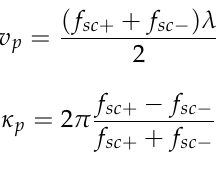
( c ) Figure 6. FEM models for the three types IDTs: ( a ) bidirectional IDT, ( b ) EWC/SPUDT, and ( c ) split IDT. The thickness of Al is normalized by the SAW wavelength λ , which equals the IDT period. The thickness of 128 ° YX-LiNbO 3 and PML were 5 λ and 1 λ , respectively. The other parameters were the same as in Section 3.1. The velocity